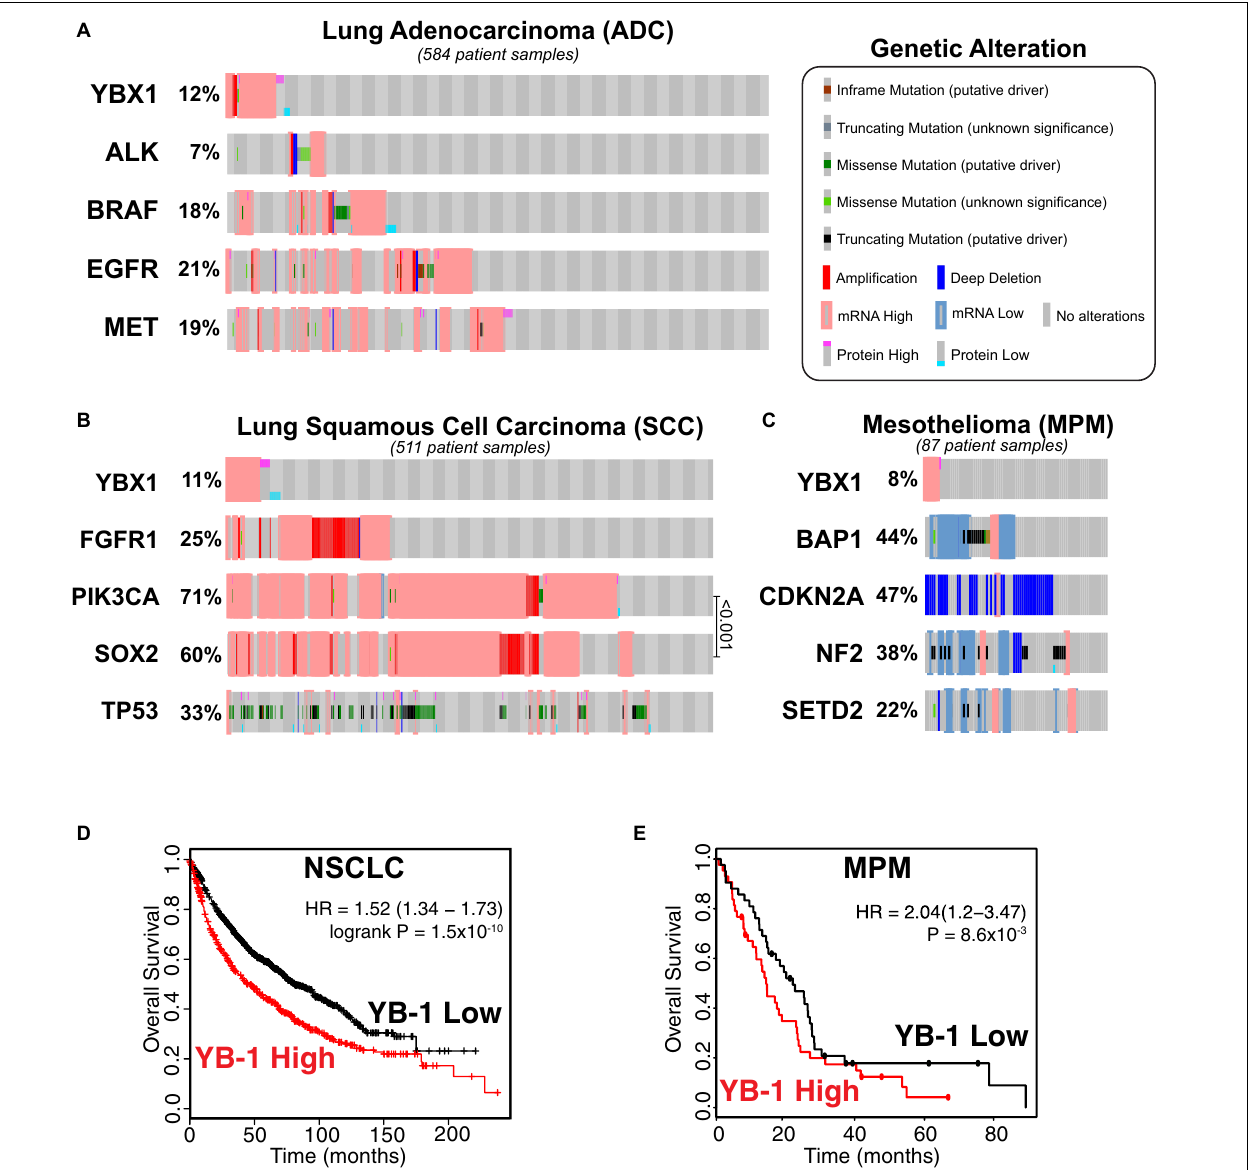
FIGURE 1 | YB-1 is altered in NSCLC (ADC and SCC) and MPM patients and high YBX1 mRNA expression correlates with poor prognosis in both diseases. Reported alteration frequencies of YBX1 and commonly altered genes in current TCGA Provisional datasets for all complete tumors with RNASeq V2 RSEM mRNA and RPPA protein Expression for (A) Lung Adenocarcinoma (ADC; n = 584), (B) Lung Squamous Cell Carcinoma (SCC; n = 511) and (C) Mesothelioma (MPM; n = 87). Panels (A–C) were adapted from the open-source platform cBioPortal for Cancer Genomics (cBioPortal.org). (D) High YBX1 expression correlates with poor prognosis in NSCLC patients ( p = 1.5 × 10 − 10 ). Kaplan-Meir plot of 1,926 NSCLC patients generated using Lung Cancer KM plotter. Univariate analysis with probe set 20862_s_at ( YBX1 ) using auto-selected cutoff and excluded biased arrays. (E) High YBX1 expression correlates with poor prognosis in MPM patients ( p = 8.6 × 10 − 3 ). Kaplan-Meir plot was generated using PROGgene V2 with the TCGA mesothelioma dataset ( n = 83) using “DEATH” as the survival measure and median as the